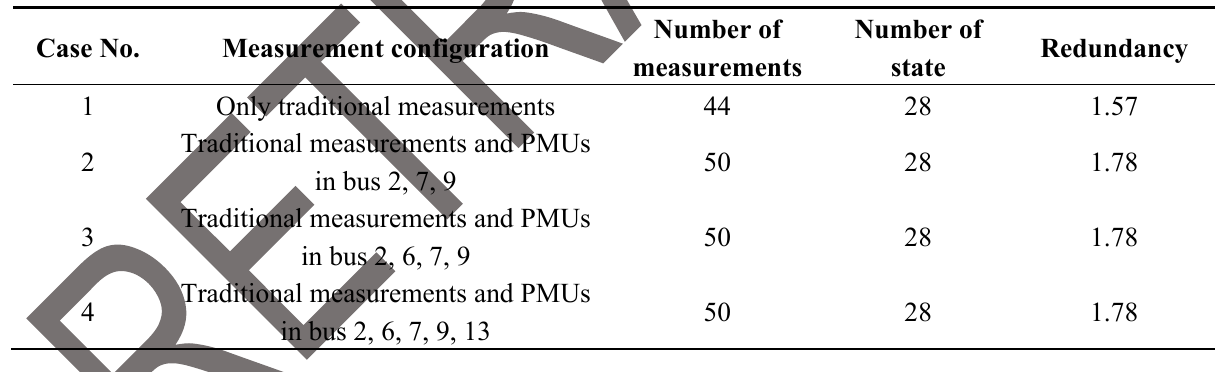
Table 1. Parameter configuration of the cases used in